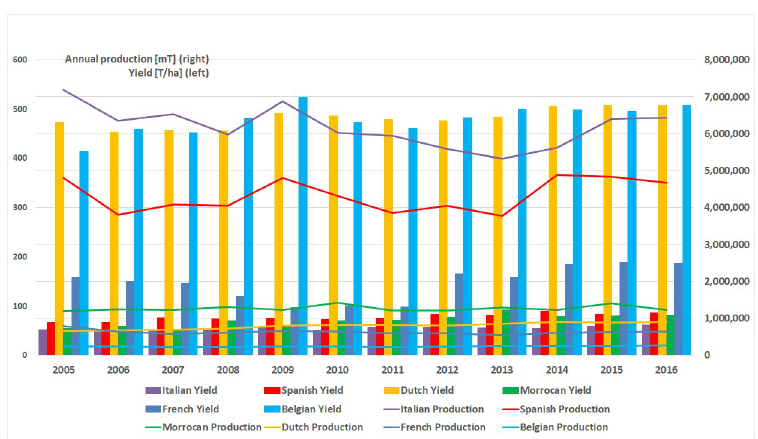
Fig 8. Evolution of the tomato production of export competitors in the European market